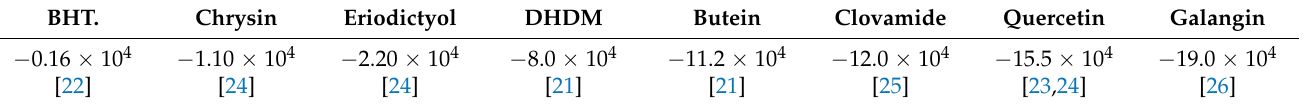
Table 3. RRDE efficiency slopes of various polyphenols.